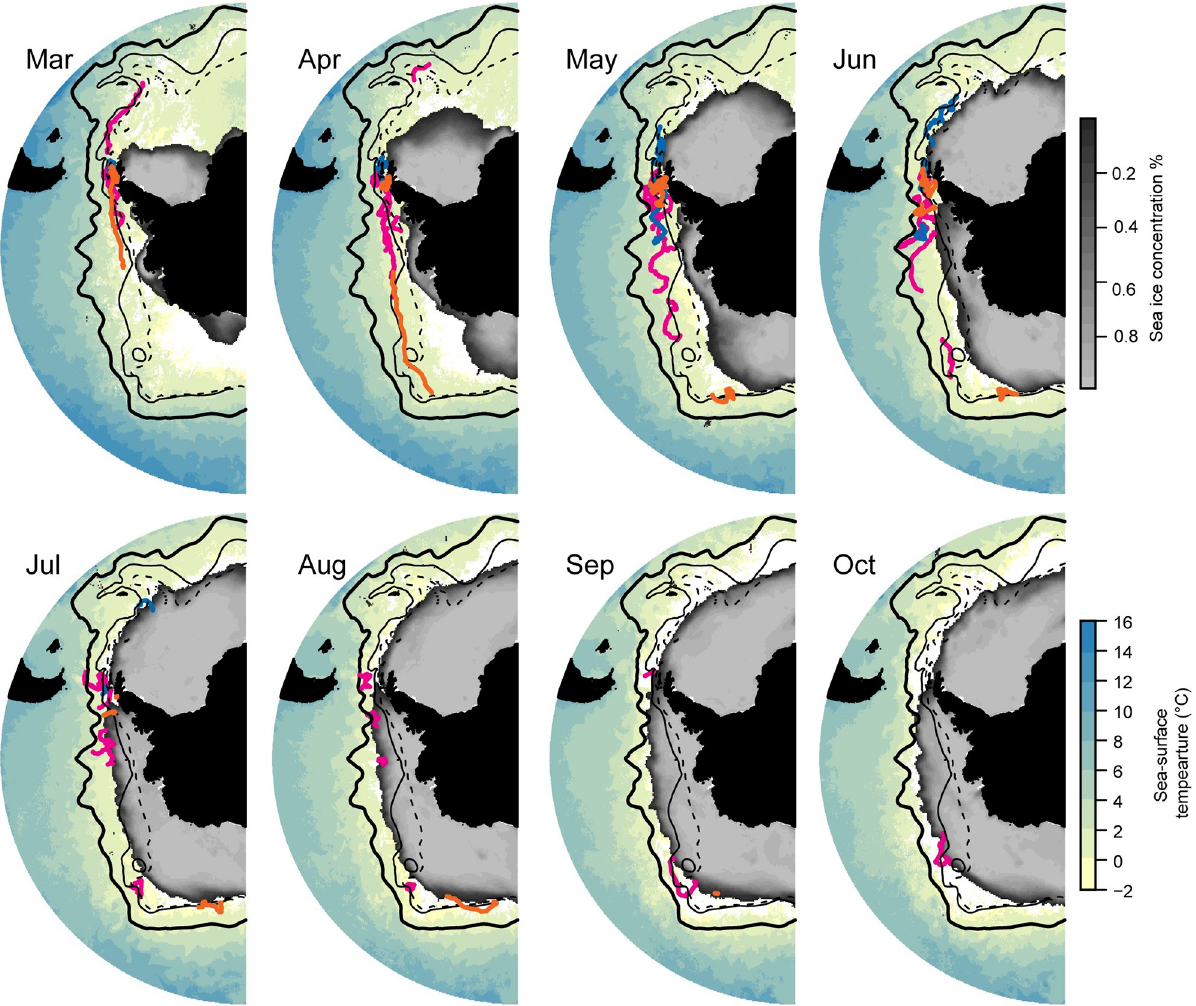
Fig 2. Monthly maps of penguin positions and environmental conditions. Monthly at-sea locations of all chinstrap penguins originating from Admiralty Bay (blue), Cape Shirreff (magenta), and Cierva Cove (orange) overlaid on mean monthly sea-surface temperatures and mean monthly sea- ice concentrations, March—October, 2017. The Polar Front (thick solid line), southern Antarctic circumpolar current front (thin solid line) and southern boundary of the Antarctic circumpolar current (thin dashed line) are plotted for reference. White areas indicate no data.